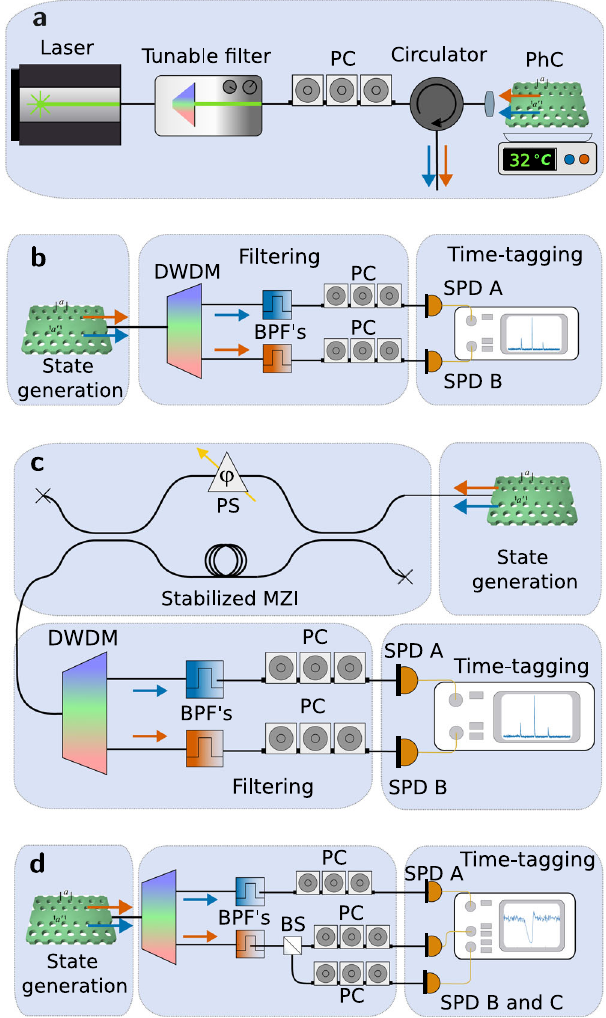
Fig. 6 Experimental setups. a Experimental setup for the generation of the photon pairs in the PhC cavity. PC stands for polarization controller. The blue and red arrows denote signal and idler photons. b Time-correlation measurement setup. DWDM stands for dense wavelength division multiplexing, BPF for bandpass fi lter, and SPD for single-photon detector. c Time-energy entanglement measurement setup. PS stands for phase shifter, MZI for Mach – Zehnder interferometer. d Heralding single-photon emission measurement setup. BS stands for beam-splitter, here with a ratio of